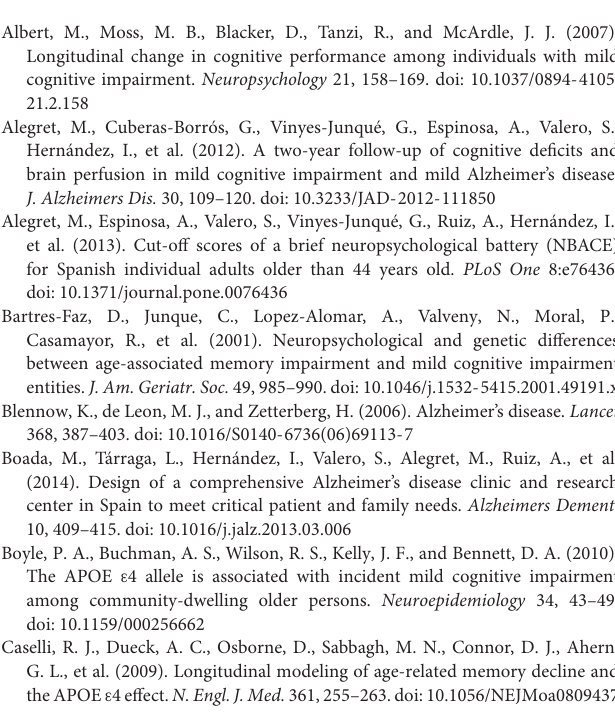
TABLE S1 | Comparison of demographic, clinical and APOE-e4 data among the stratified four MCI phenotypes from ACE dataset. TABLE S2 | (A) Comparison of demographic, clinical and APOE-e4 data between patients with aMCI and naMCI phenotypes from the AgeCoDe dataset. (B) Comparison of demographic, clinical and APOE-e4 data between patients with aMCI and naMCI phenotypes from the DCN dataset. (C) The ANCOVA NE scores between aMCI and naMCI groups from the AgeCoDe dataset. (D) The ANCOVA NE scores between aMCI and naMCI groups from the DCN dataset. TABLE S3 | The ANCOVA comparing NE scores among the stratified four MCI phenotypes from ACE dataset. TABLE S4 | Genetic effects on NE in the four stratified MCI phenotypes from ACE dataset.